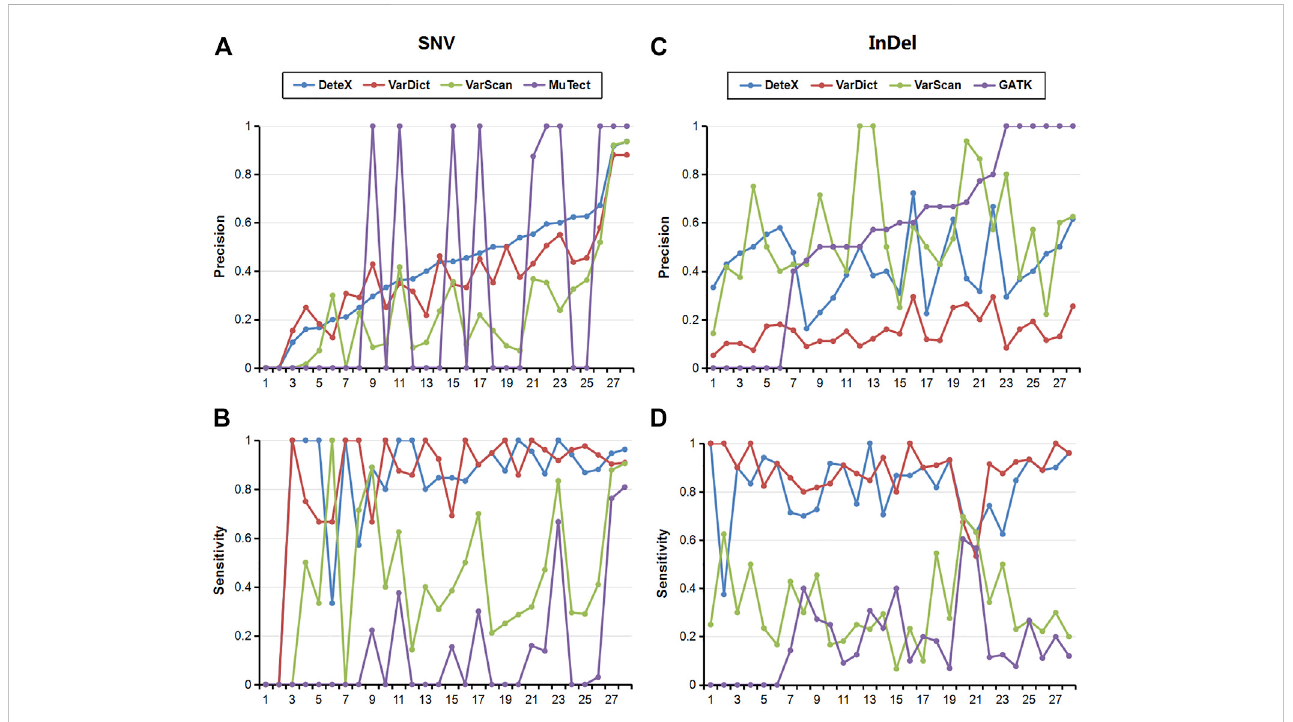
FIGURE 2 Sensitivity and precision of each software for the detection of SNV and InDel in 28 clinical samples. (A) Precision of SNVs, (B) Sensitivity of SNVs, (C) Precision of InDels, (D) Sensitivity of